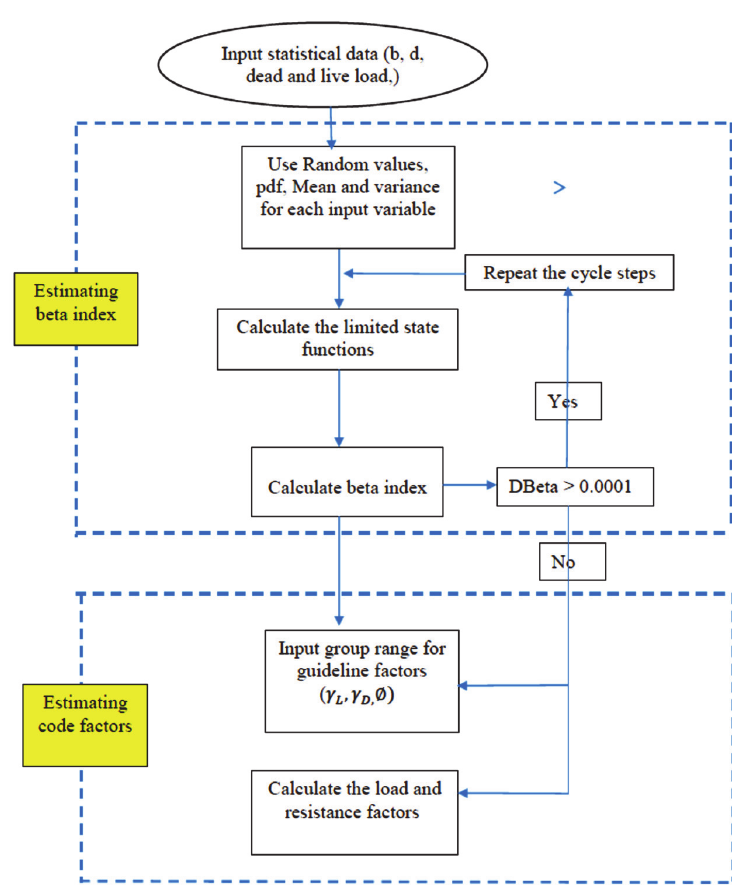
Figure 2: Flowchart of computer code to estimate the beta index and load